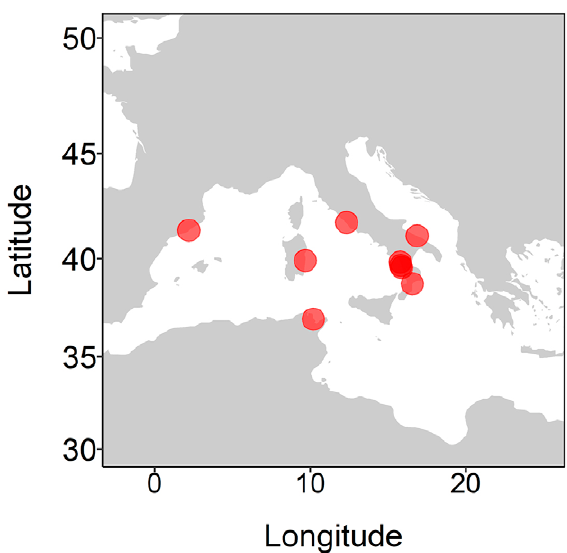
Fig. 3. – The removal of underwater plastic debris fostered or organ- ized by Plastic-Free Spearfishing